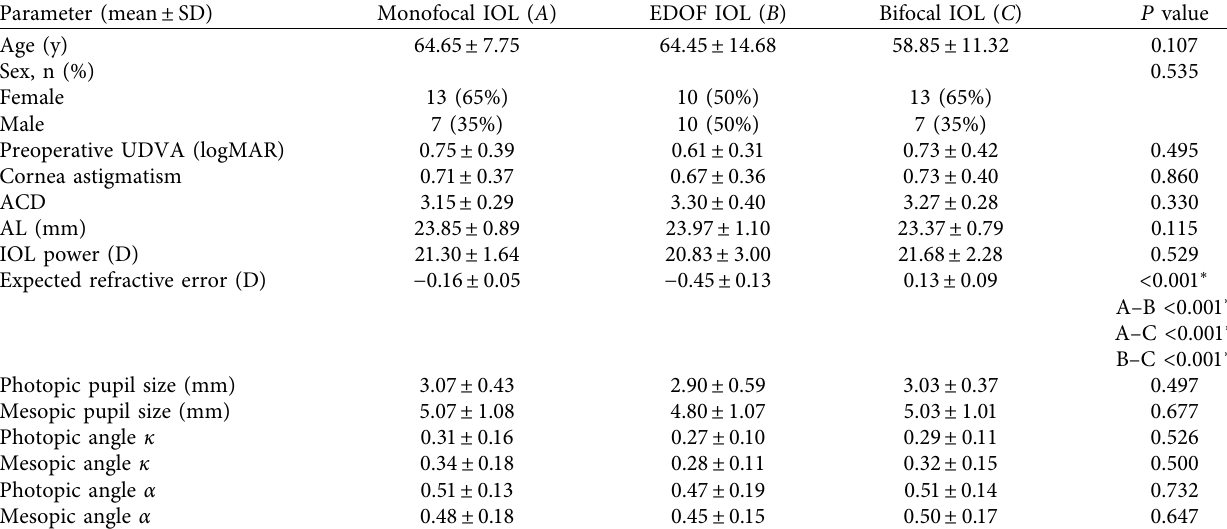
Table 1: Intragroup comparison of baseline characteristics in the 3 IOL groups.